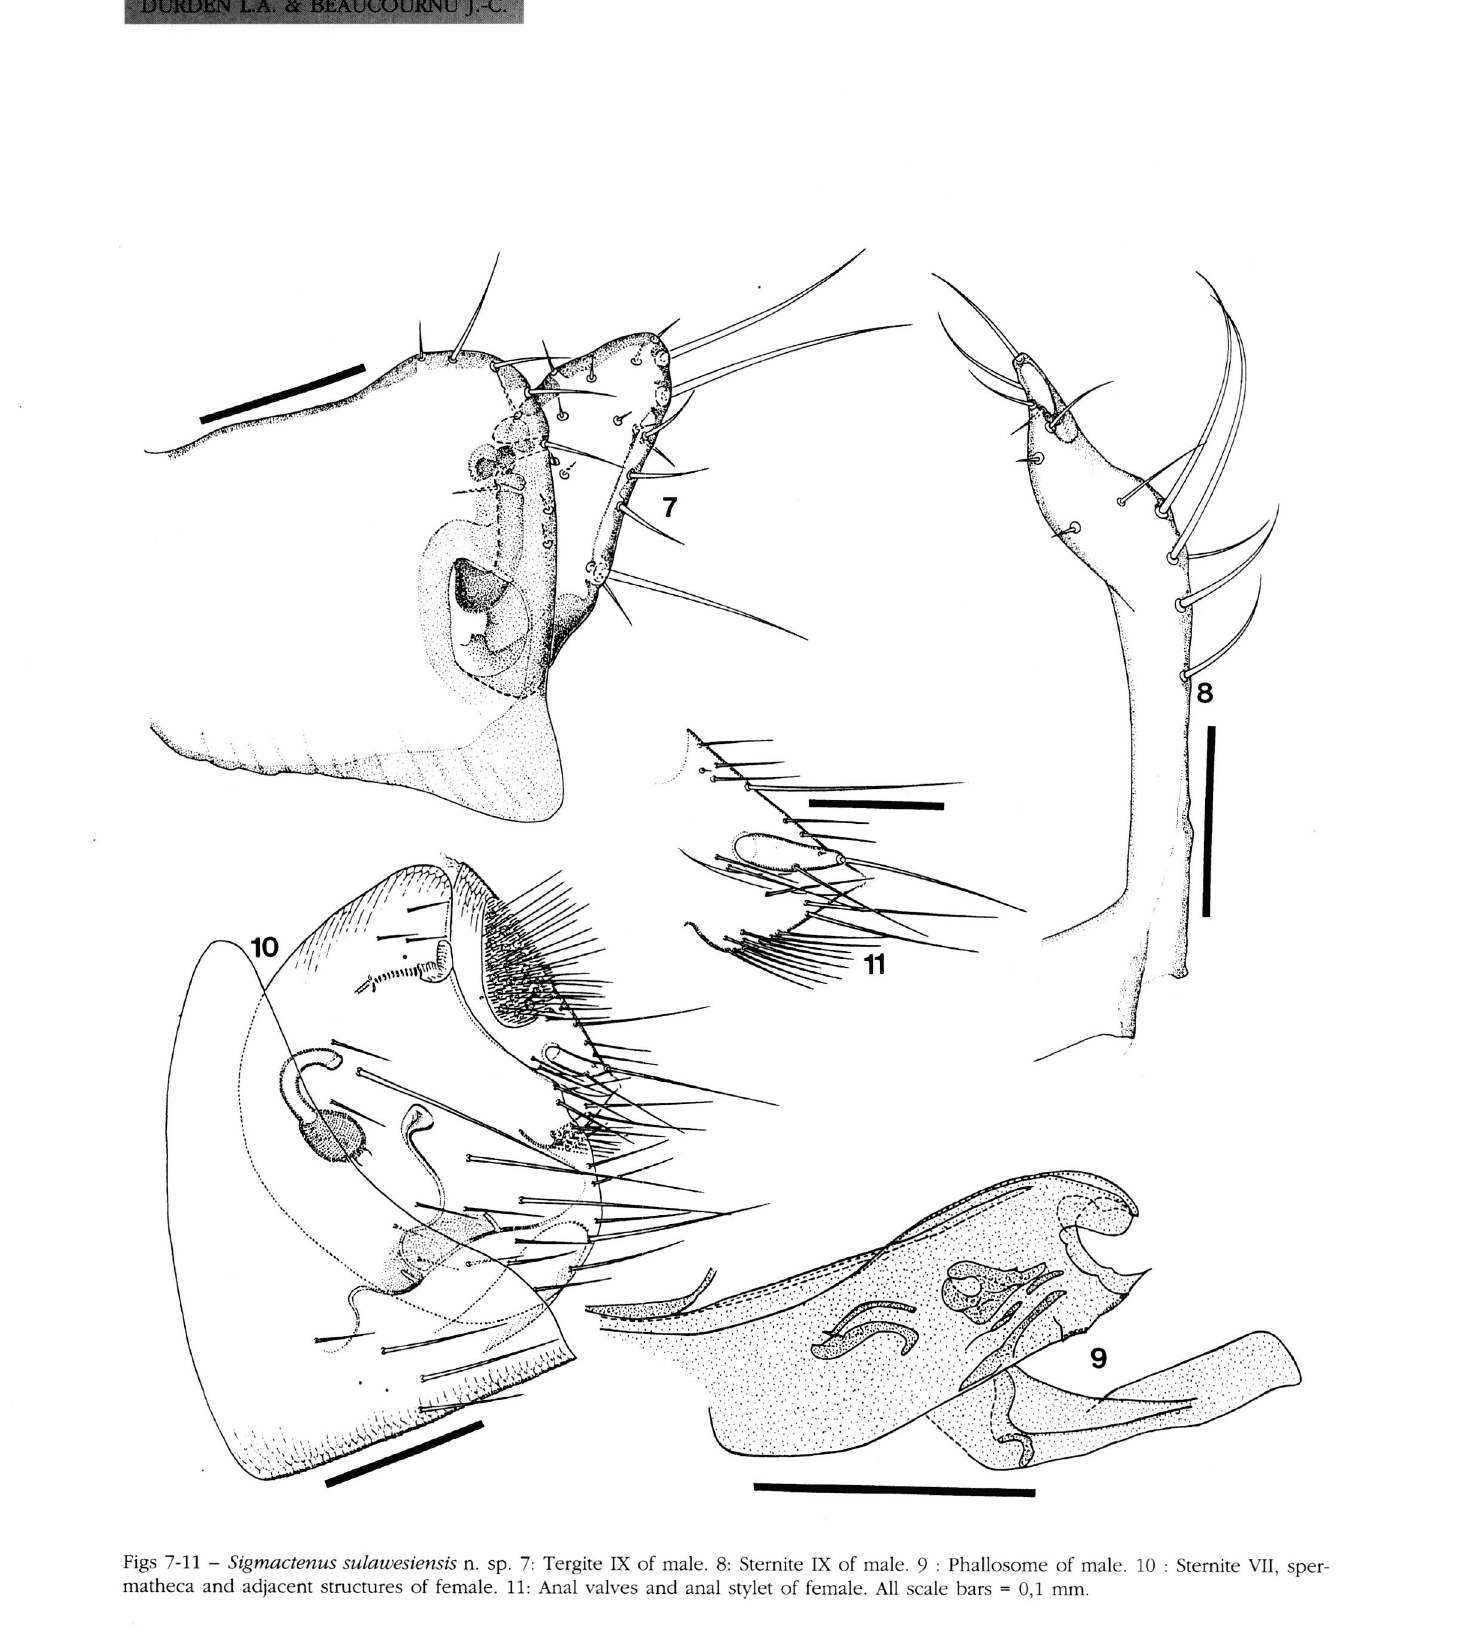
154 Mise au pain Parasite, 2000, 7,